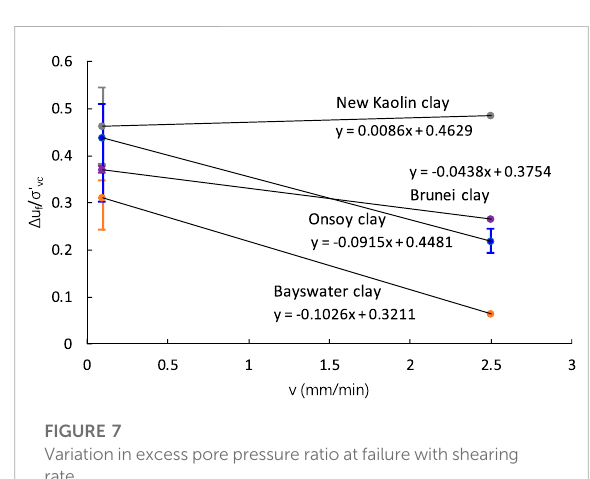
FIGURE 4 Variation in undrained strength ratio with vertical consolidation stress.